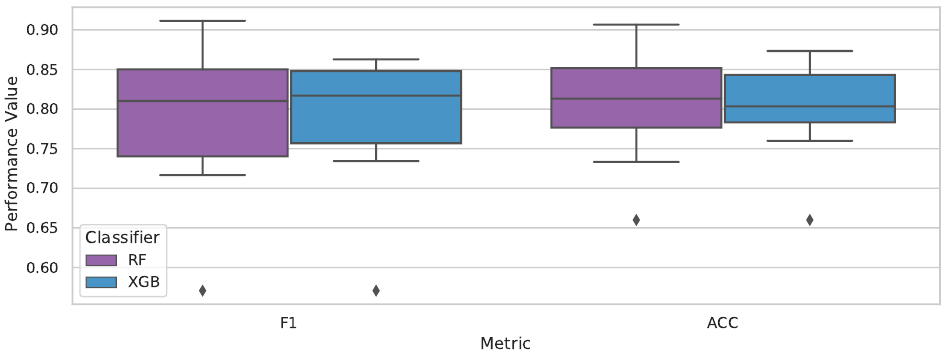
Figure 4. Predictive performance of RF and XGB classifiers using word2vec